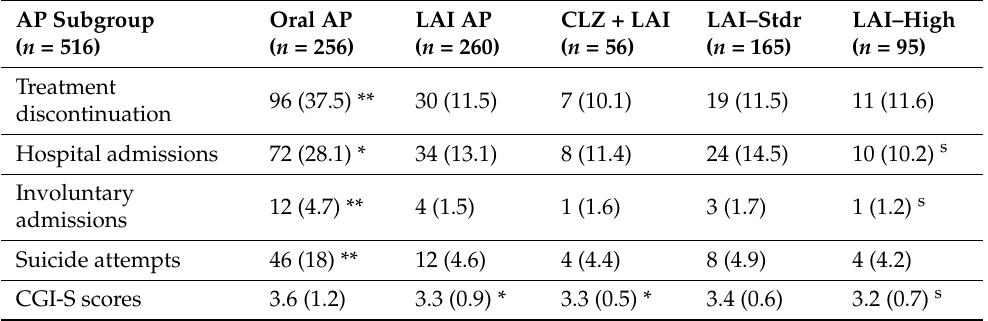
Table 3. Treatment discontinuation, hospital admissions, suicide attempts [ n , %], and CGI-S scores [Av (SD)] after 5 years.